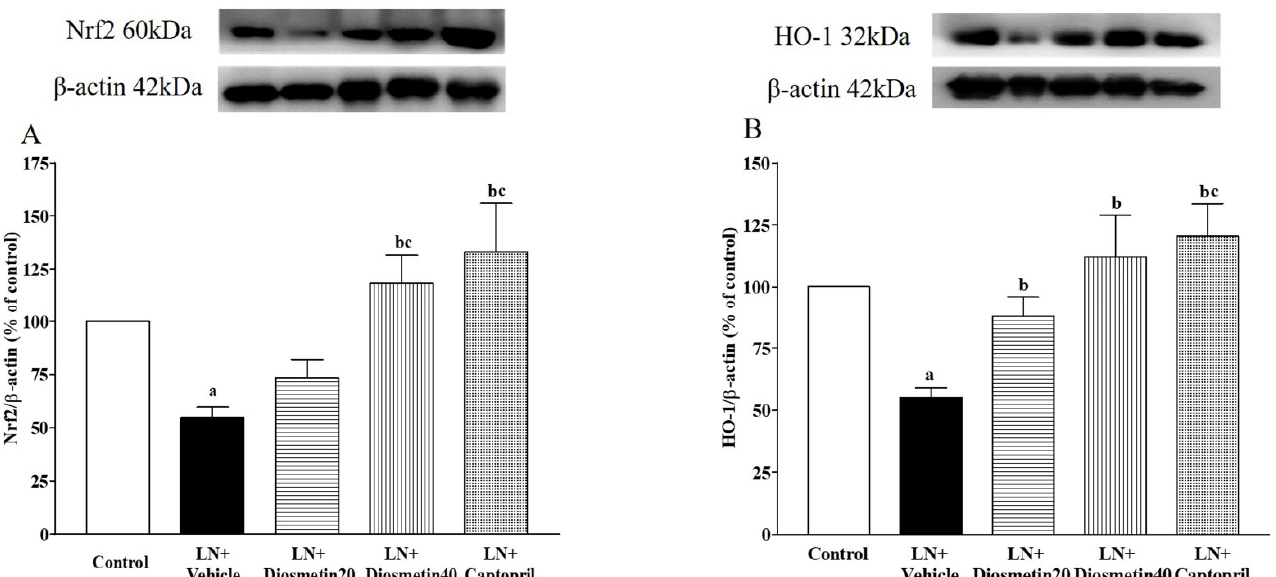
Figure 6. Effect of diosmetin and captopril on Nrf2 ( A ) and HO-1 ( B ) protein expression in vascular tissue. a p < 0.05 vs.